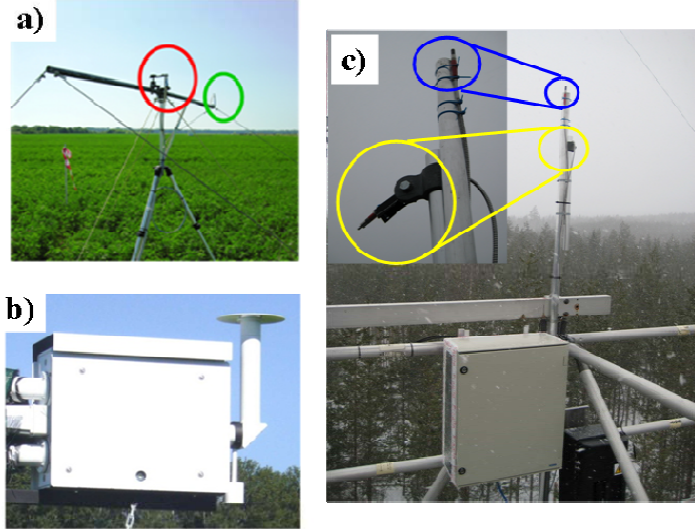
Figure 4. Pictures of the systems installed in the field. (a) Optics of the MRI mounted on a tripod (cosine receptor head in red; bare fiber position in green). (b) Picture of the HSI box installed in field. (c) Two Dual Field of View (DFOV) system installed at Hyytiälä site, Finland (upward pointing cosine receptor in blue; downward fiber in